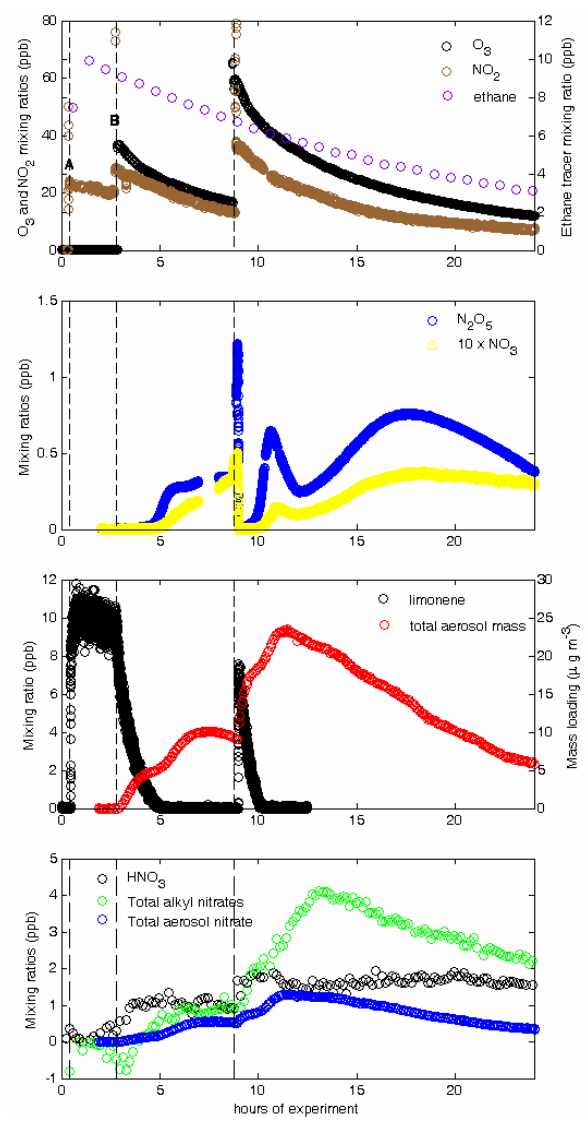
Fig. 1. Overview time series of species monitored. Ethane was used as an inert dilution tracer. Chamber temperature was between 288-296 K for the duration of this experiment. Dashed vertical lines refer to key changes in chamber composition, described in detail in the text. At A, first limonene was injected; at B, oxidative chemistry was initiated by addition of ozone; at C, a second batch of limonene and oxidants was injected.